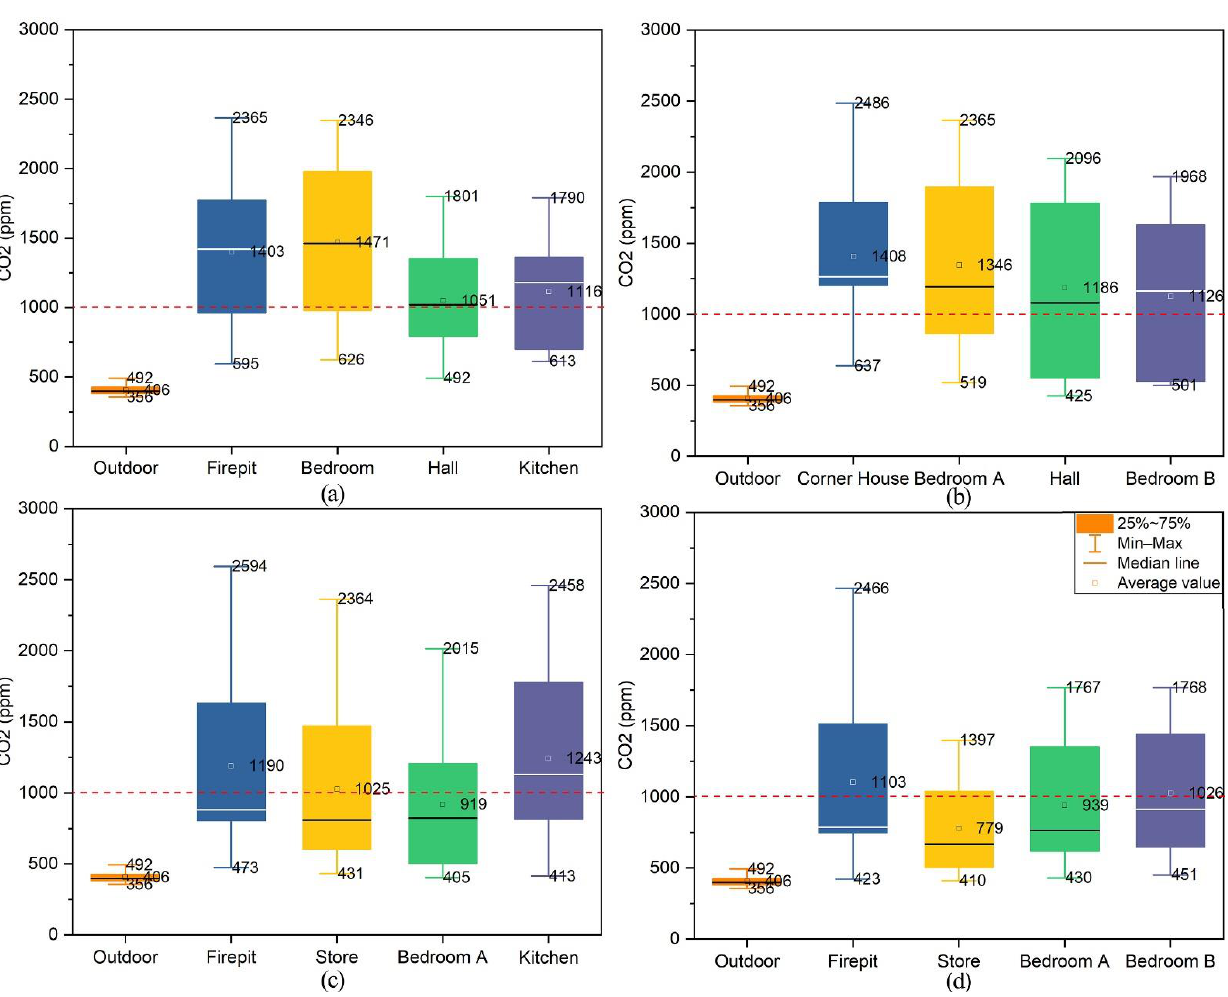
Figure 11. Analysis of CO 2 concentrations during indoor fires in ancient Tujia town dwellings. ( a ) Zuozi dwelling [34]. ( b ) L-shape dwelling [34]. ( c ) lower store and upper house dwelling. ( d ) front store and back house dwelling.